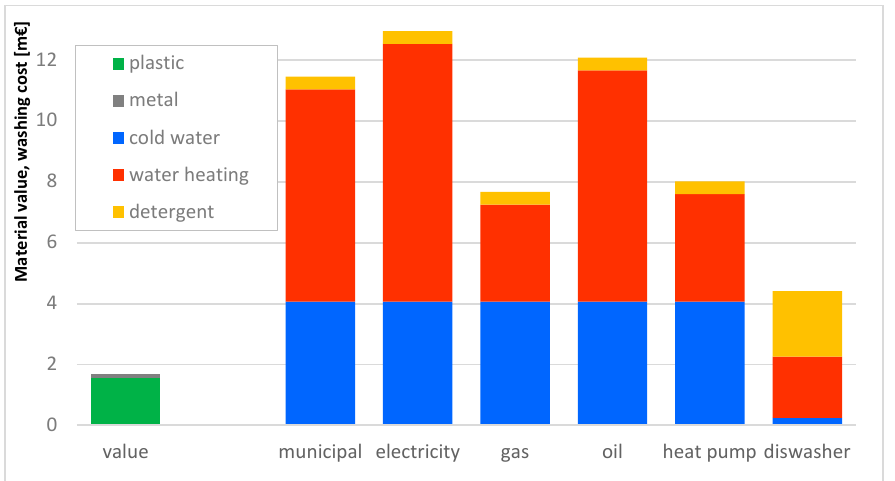
Figure 5. Average values of various methods of water heating costs for washing a single glass packaging.